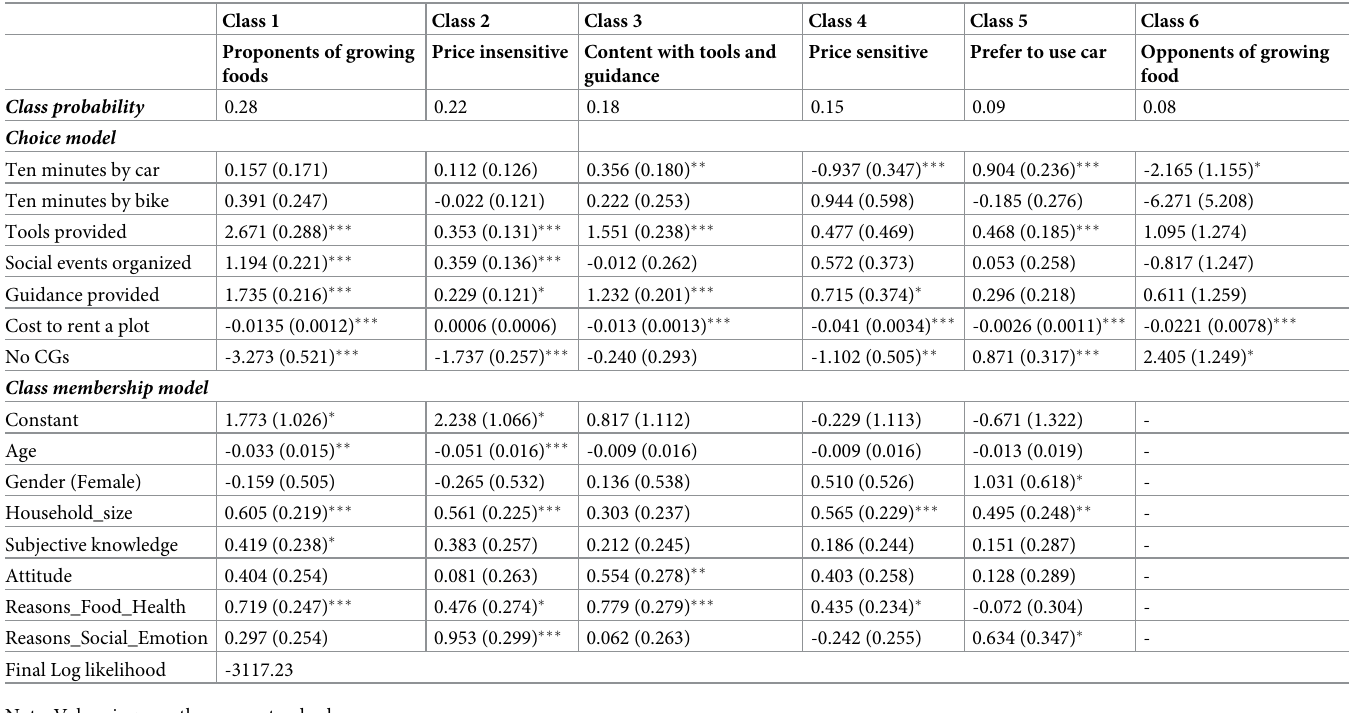
Table 6. Estimation results from latent class